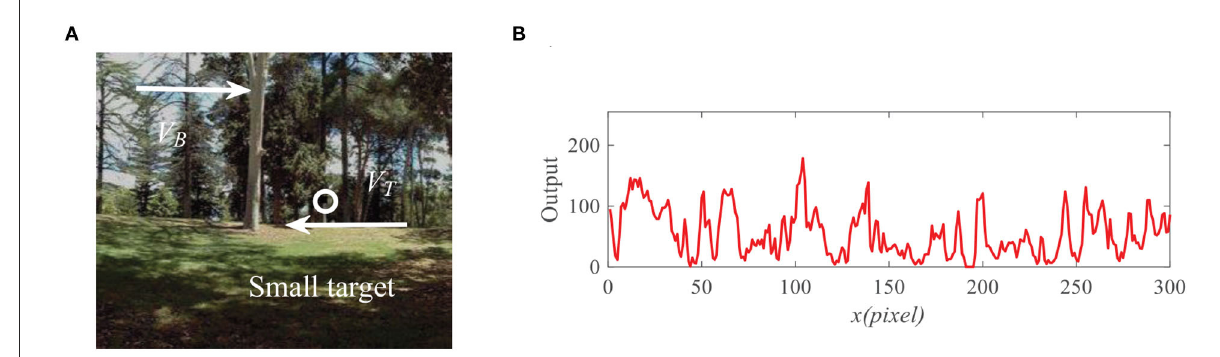
FIGURE7 (A) Input image at time t 0 430ms, where a small target (the black block) is moving against the cluttered natural background. Arrow V B denotes = motion direction of the background and V T denotes motion direction of the small target. (B) Input signal with respect to x for the given y 0 pixels and time t 0 430ms. =